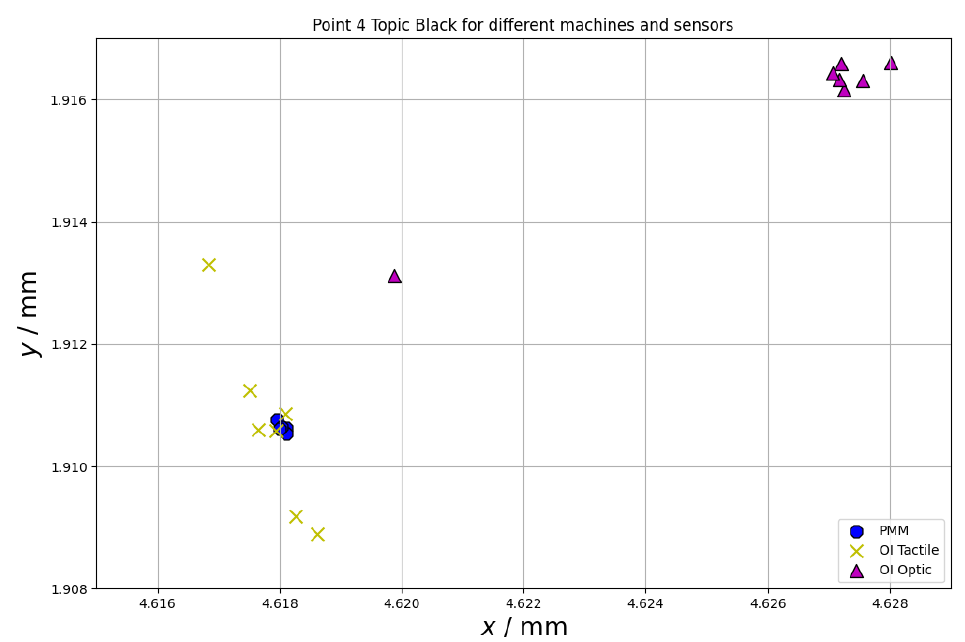
Figure 10. Repeatability of measuring point for chosen point at the equator of the sphere made of Topic Black.